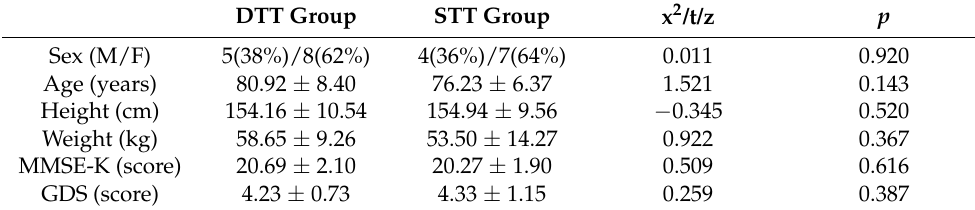
Table 2. General characteristics.